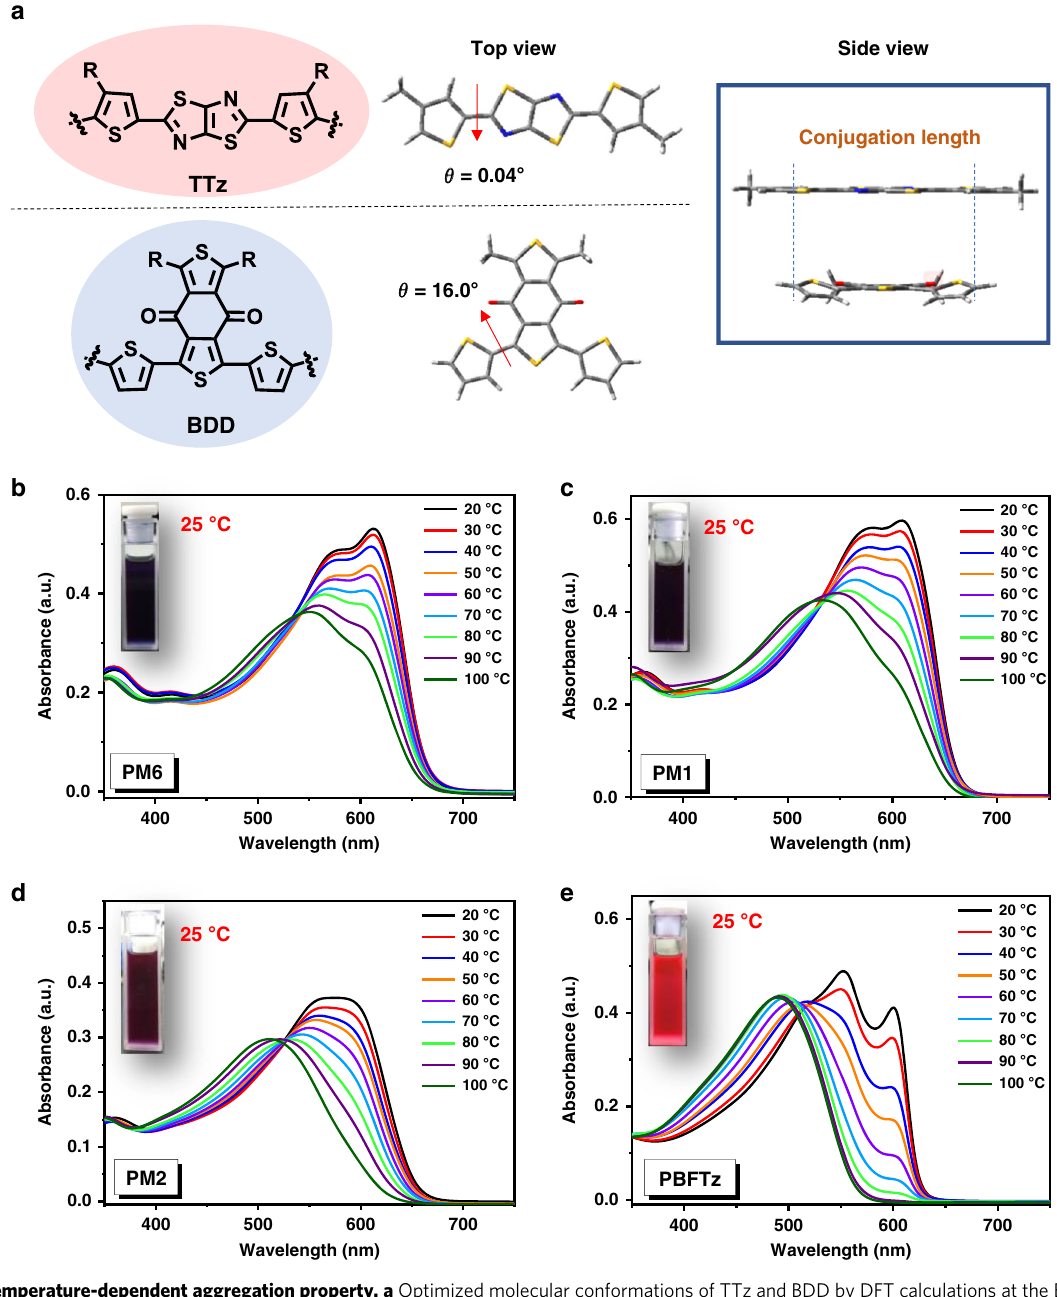
Fig. 2 The temperature-dependent aggregation property. a Optimized molecular conformations of TTz and BDD by DFT calculations at the B3LYP/6-31G (d, p) basis set with simpli fi ed alkyl substituents. b – e Optical absorption of the polymers in chlorobenzene at various